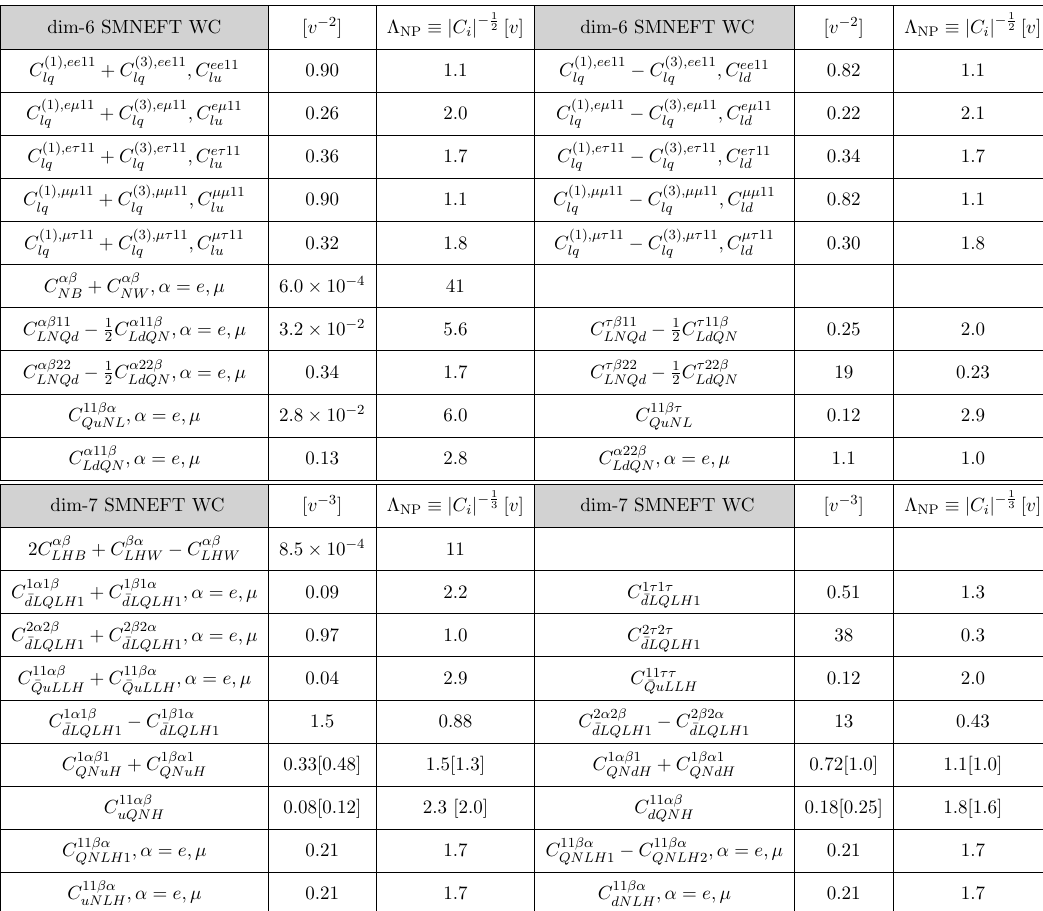
Table 5 . Constraints on the Wilson coe(cid:14)cients of the relevant dim-6 and dim-7 SMNEFT from the strongest limits for the corresponding LNEFT WCs in the gray sector of table 3 and table 4, where v ’ 246 GeV is SM Higgs vacuum expectation value. For the dim-7 scalar type operators, the numbers outside [inside] the square bracket indicate the case with the neutrino (cid:13)avors (cid:11) 6 = (cid:12) [ (cid:11) = (cid:12)